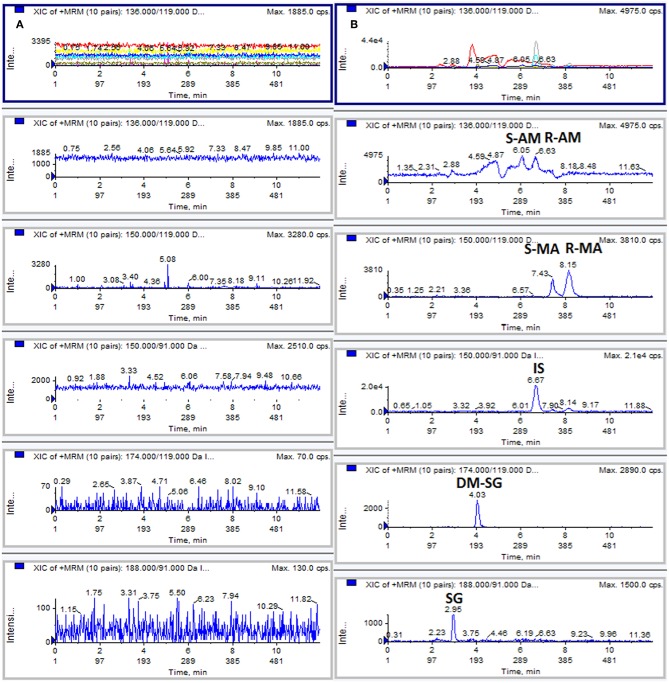
Typical MRM chromatograms: (A) blank DUS sample; (B) DUS sample spiked with analytes at the LLOQ level (50 ng/mL).